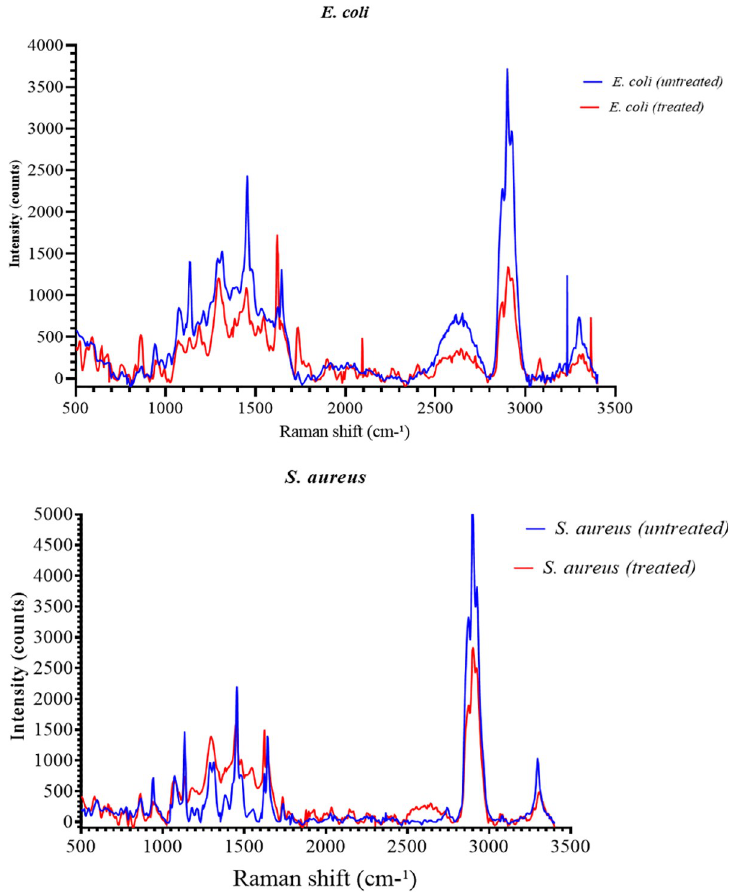
Fig 6. Raman spectroscopy of E . coli and S . aureus in greywater before and after inactivation by bimetallic Zn/Cu nanoparticles; a) E . coli ; b) S . aureus .